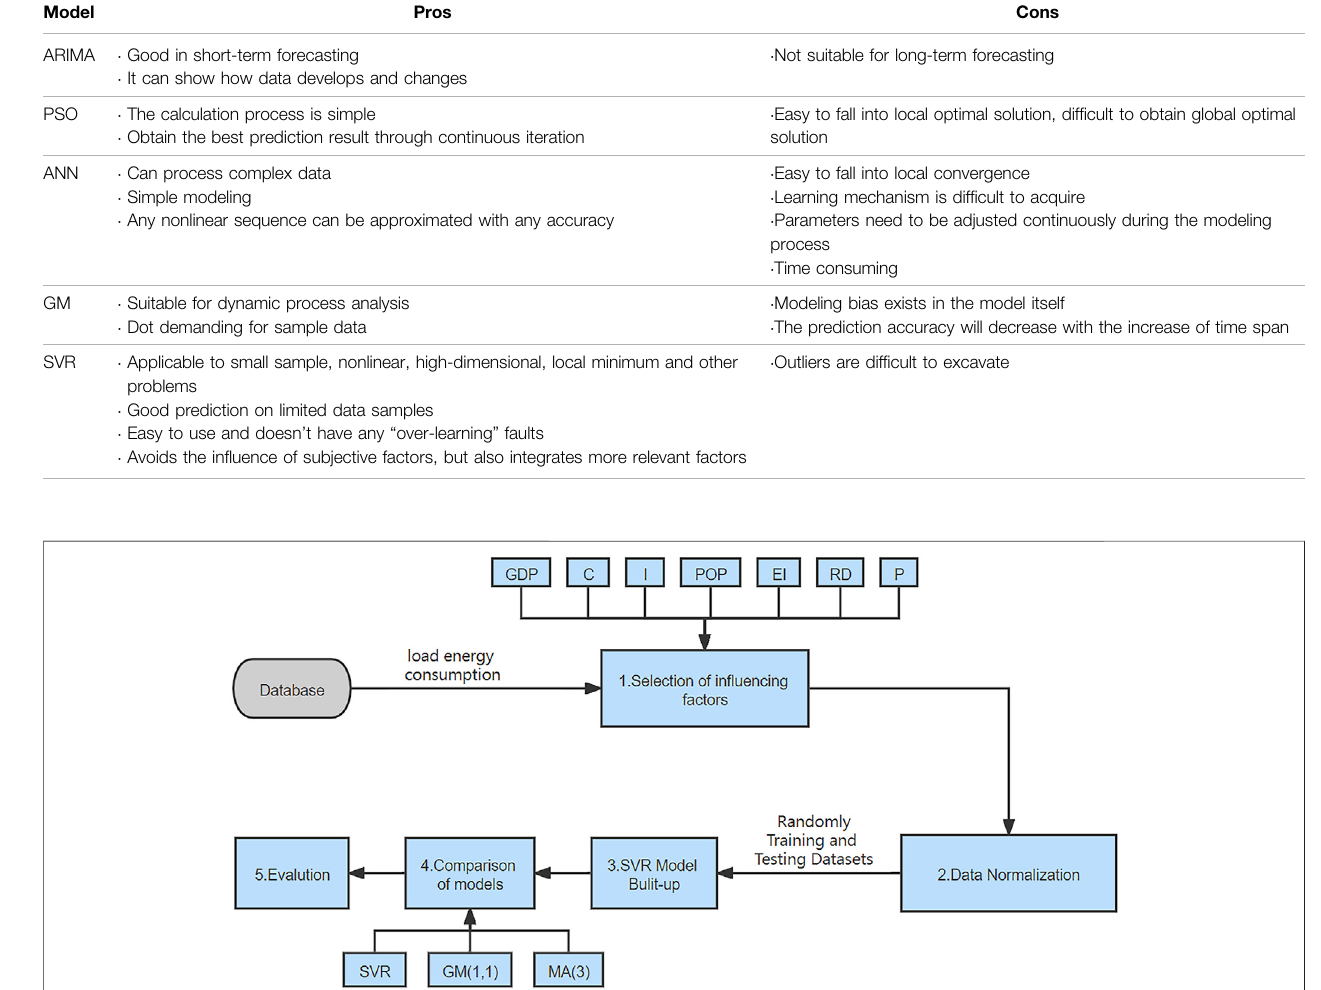
TABLE 1 | Comparison of prediction methods. Model